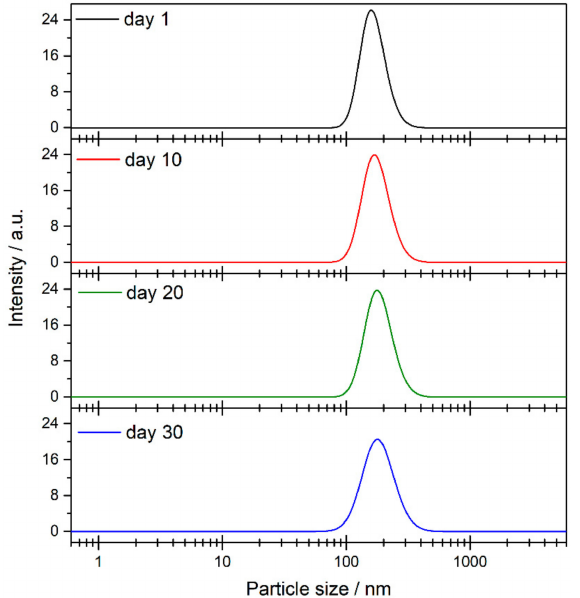
Figure 9. Results of particle size and size distribution from dynamic light scattering (DLS)